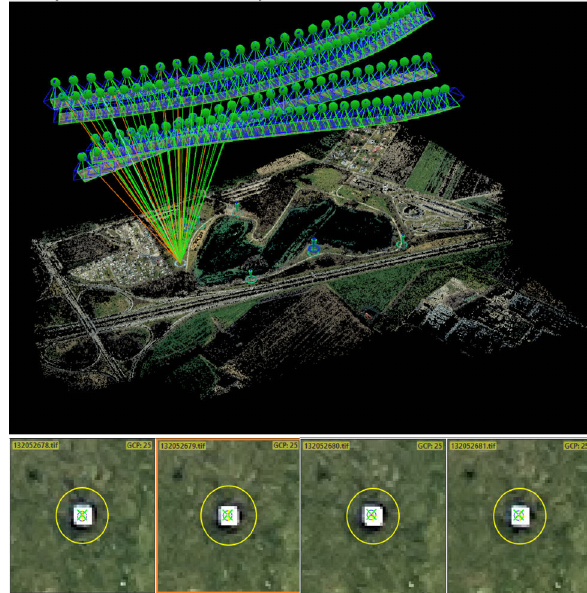
Figure 7. RGB image bundle block; top: 3D-view of automatically matched image tie points, image rays intersecting at manually measured control point 25; bottom: control point 25 displayed in images 52678-81